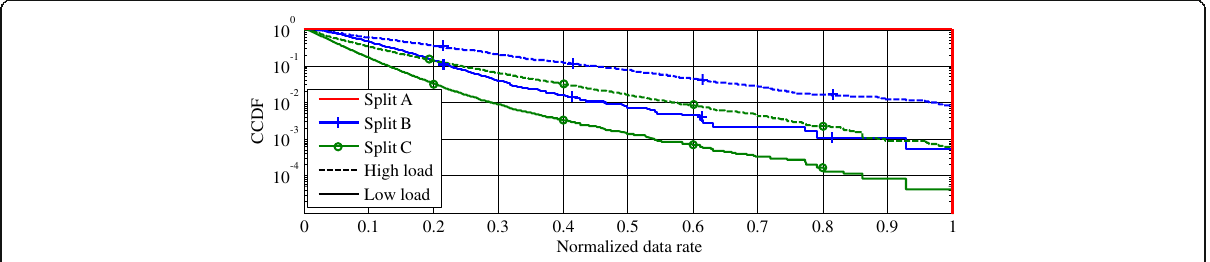
Fig. 5 CCDF of normalized data rates when employing split A, B, and